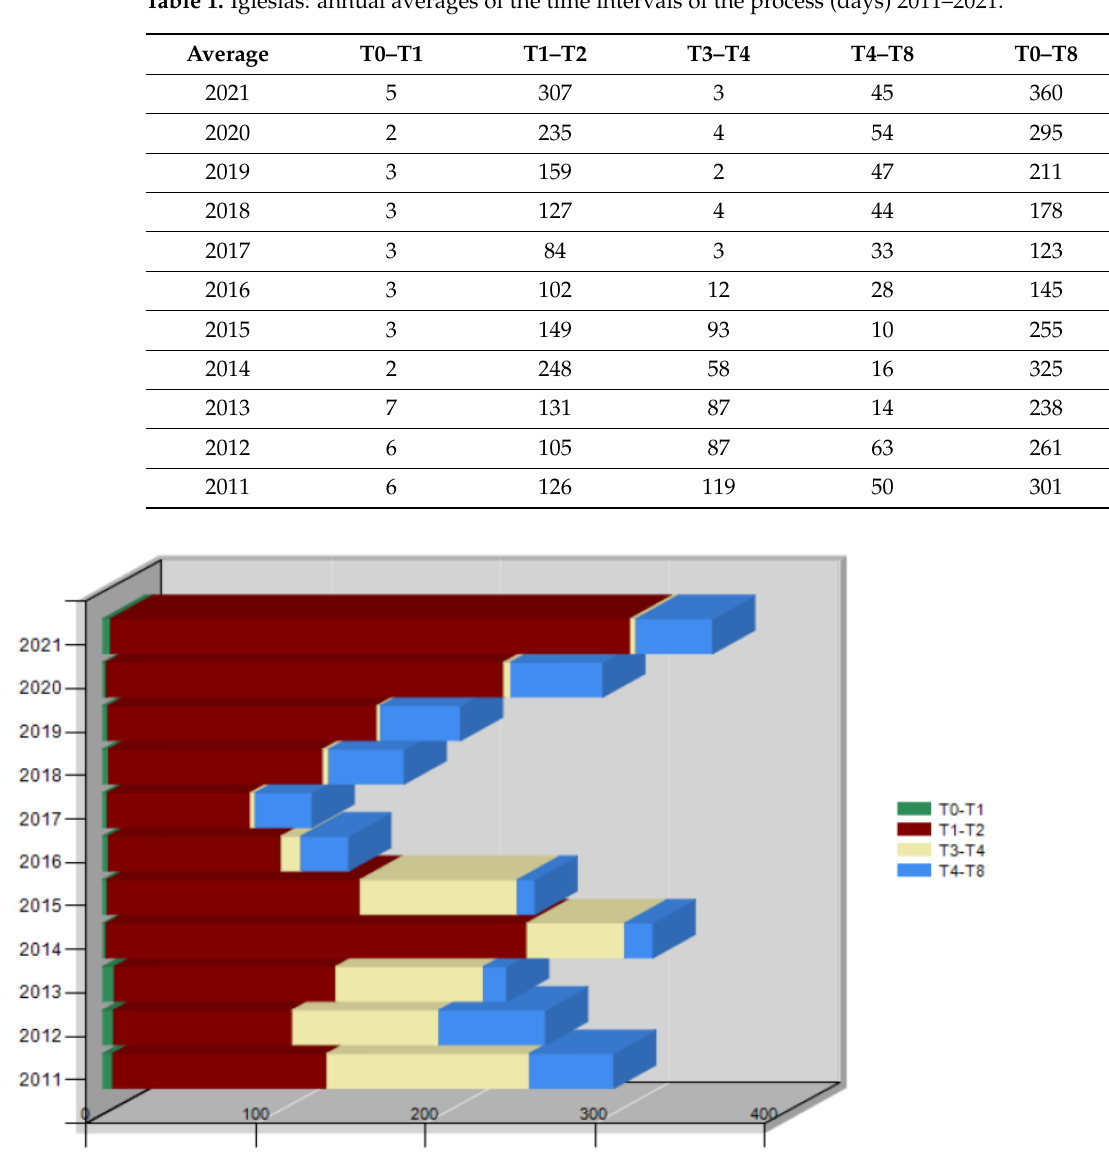
Table 1. Iglesias: annual averages of the time intervals of the process (days) 2011–2021.